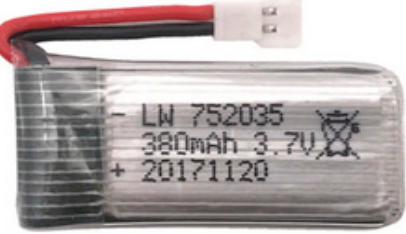
Figure 4. Picture of LiPo battery model LW 752035 (manufactured by Celewell Technology Co.).